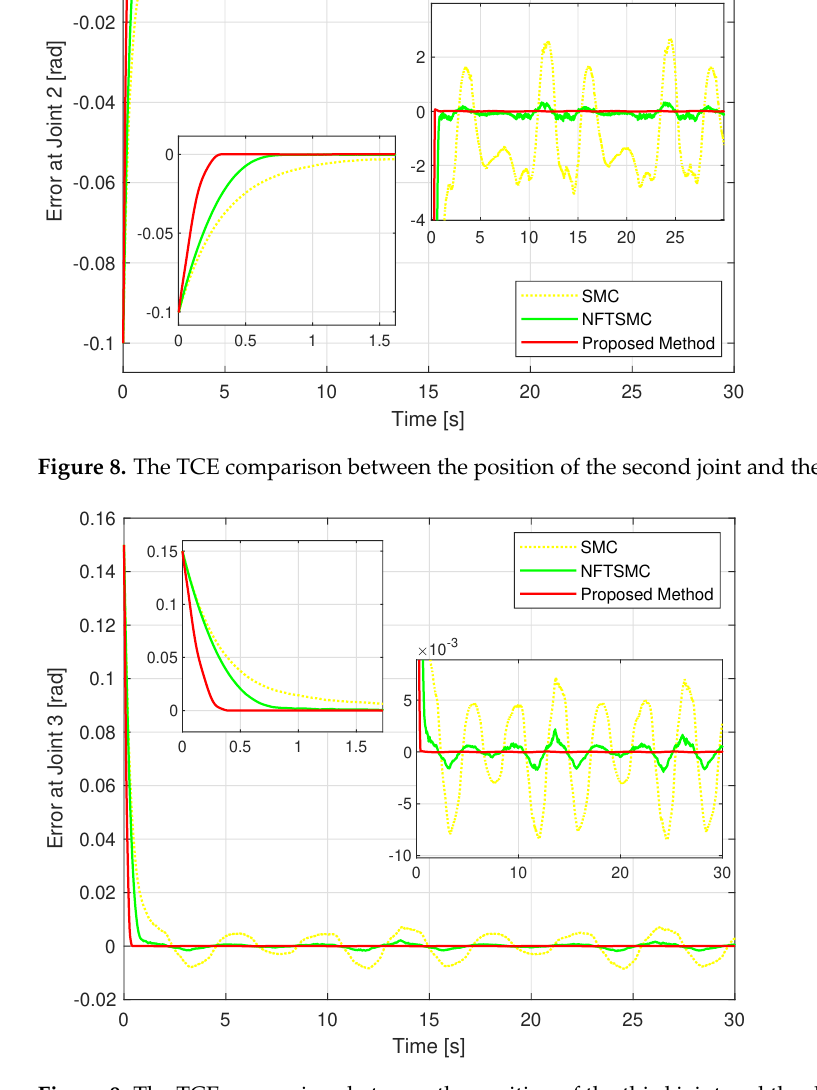
Figure 9. The TCE comparison between the position of the third joint and the desired path. In the control torque signal of the proposed method, the chattering behavior has been minimized to the smallest possible extent, as shown in Figure 10, because its discontinuous control law has been removed. Although a discontinuous control law is not used to deal with uncertain components, the robustness of the controller is achieved at a high level so that it provides good tracking accuracy. Due to using the same sliding gain to cope with the effects of uncertainties, the other two methods have similar chattering behavior. It can be concluded that the combination of the proposed USOSMO and the proposed FxPRRL is a very good solution to deal with the influence of uncertainty and